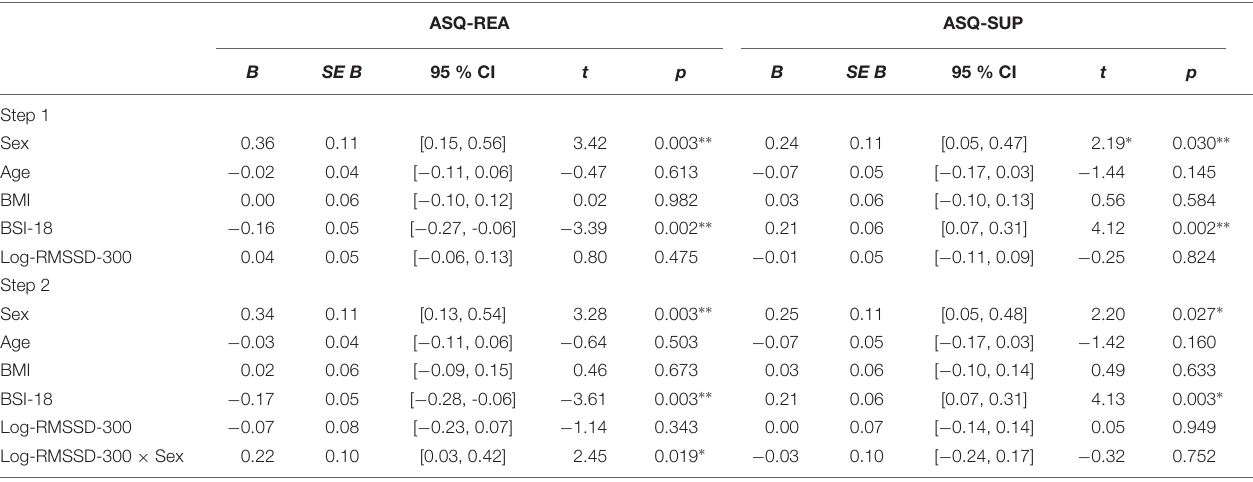
FIGURE 1 | Scatter plots with lines of best fit demonstrating bivariate correlations between self-reported reappraisal (ASQ-REA) or suppression (ASQ-SUP) use and (log-transformed) vagally mediated heartrate variability (Log-RMSSD) that was derived from 300 s (Log-RMSSD-300), 120 s (Log-RMSSD-120), or 60 s (Log-RMSSD-060) lasting resting state recordings of male (black triangulars, solid line) and female (white triangulars, dashed line) participants’ heart rate. TABLE 2 | Associations between short-term measures of heartrate variability that had been derived from 300 s lasting heartrate recordings and measures of reappraisal and